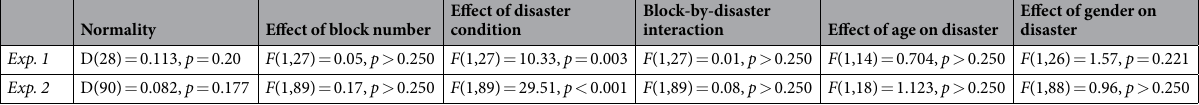
Table 1. Full statistics for Experiments 1 and 2 for analyses of the effect of disaster condition on effort